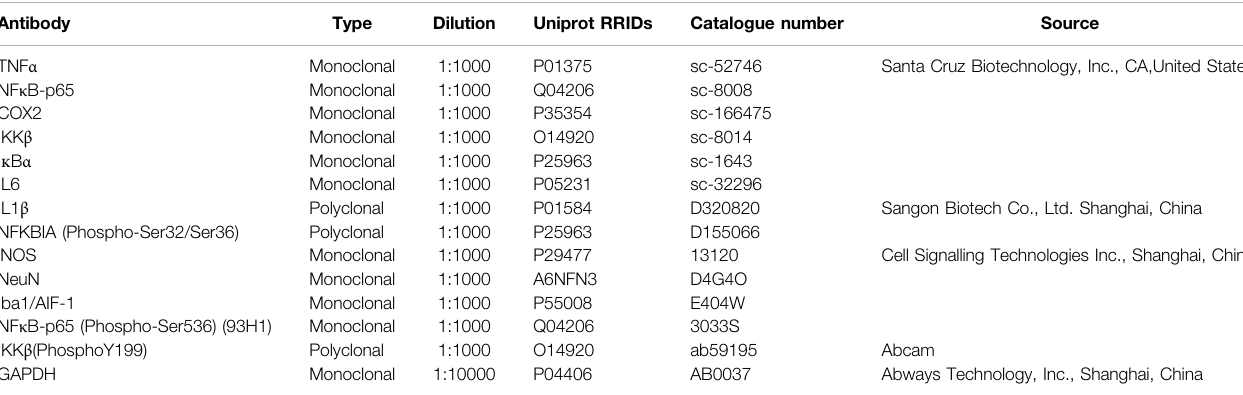
TABLE 2 | List of primary antibodies used.